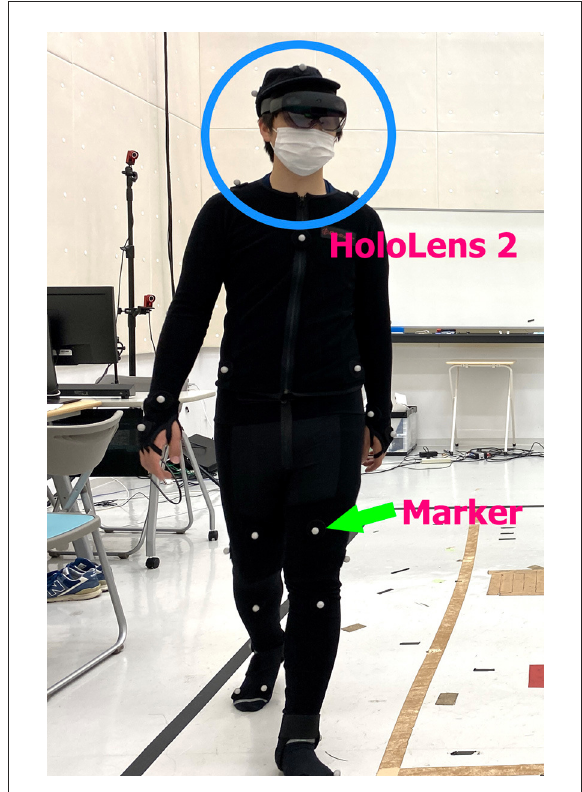
FIGURE7 A subject wearing HoloLens 2 and OptiTrack motion capture suit with 37 markers.